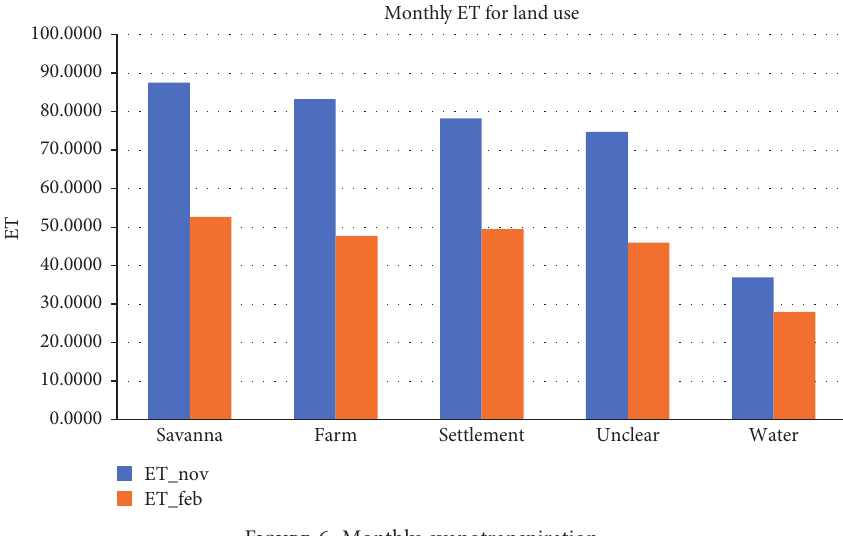
Figure 6: Monthly evapotranspiration.